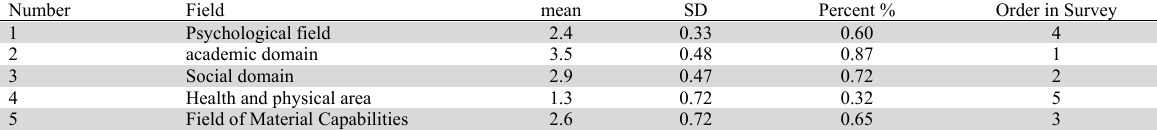
Arithmetic mean, SD and relative importance of Psychological field, academic and social domain, etc.